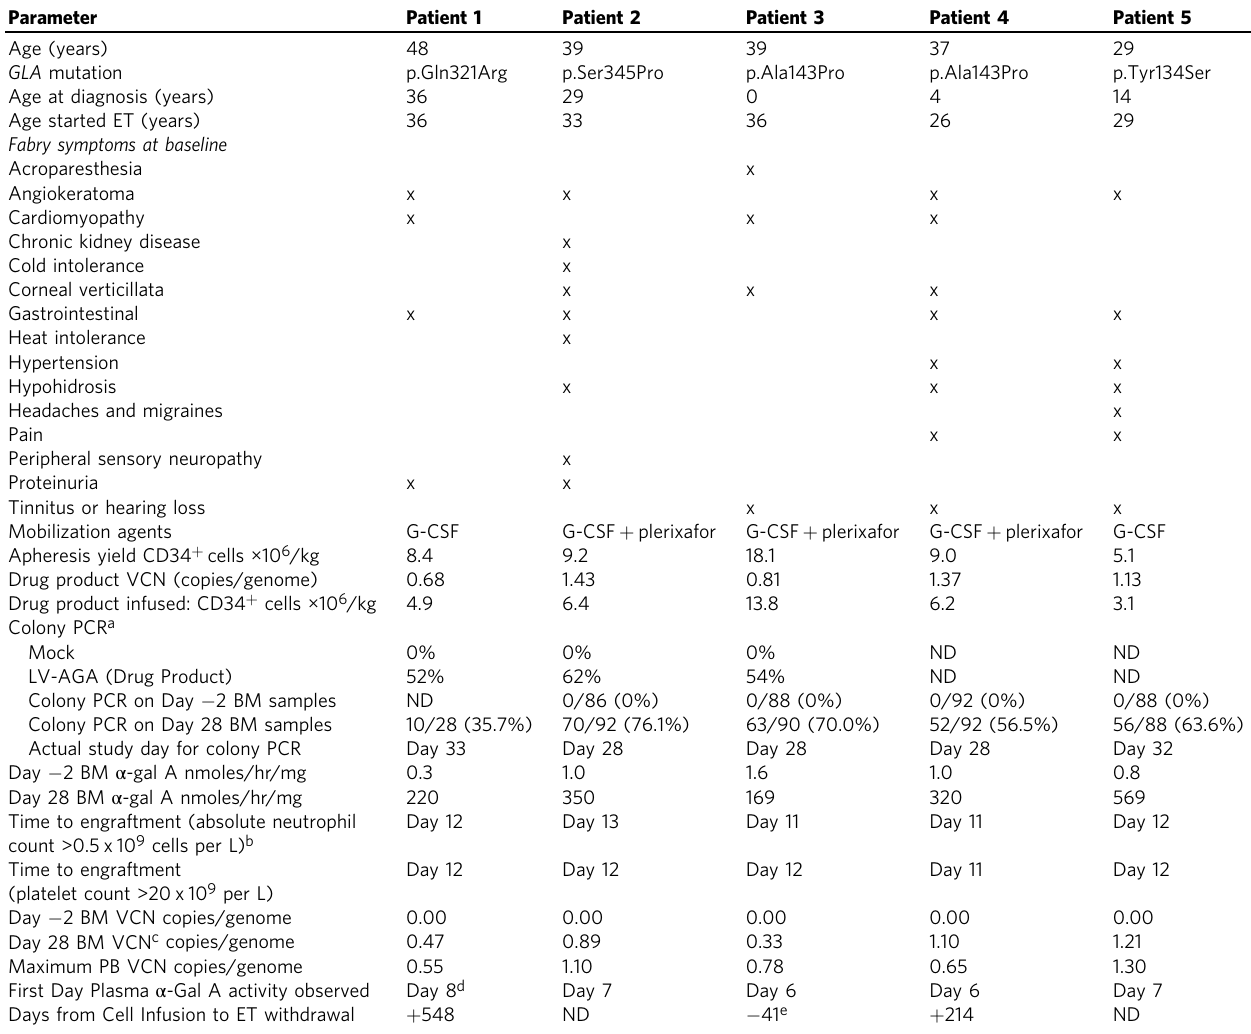
Table 1 Baseline patient demographics and treatment phase outcomes.